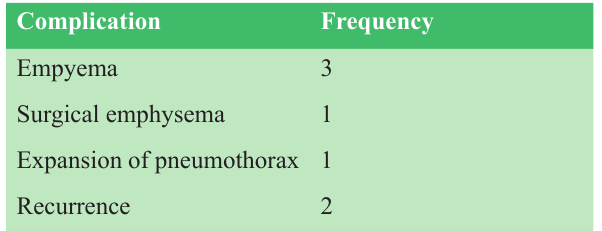
Table 5.List of